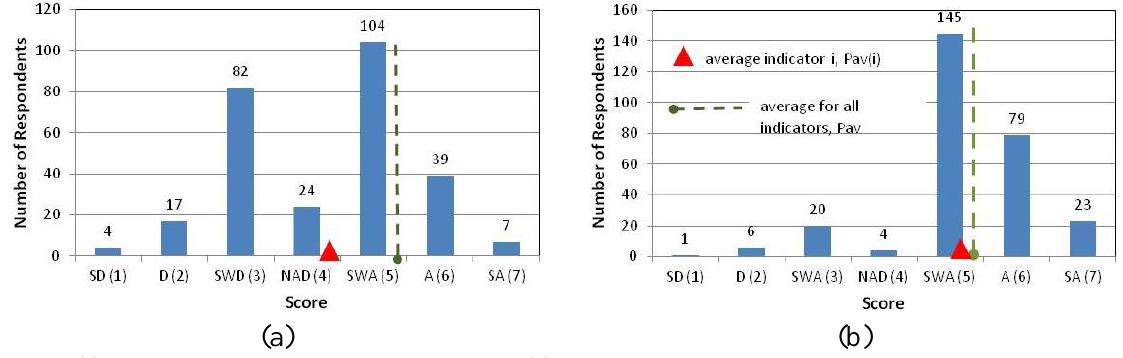
Figure 3. (a) Survey results in the form of a histogram, and (b) Conflicted